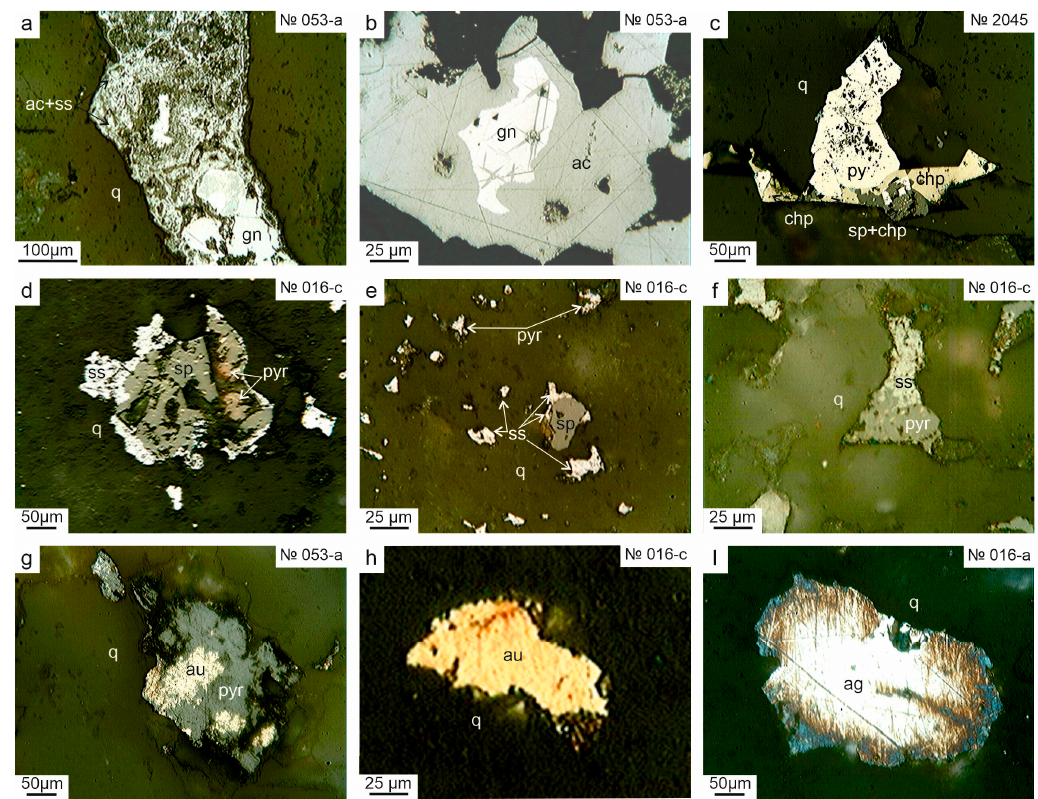
Figure 3. Mineral interrelations at the Corrida deposit: ( a )—acanthite grown on galena; ( b )—acanthite around galena and acanthite tabular isolations in galena; ( с )—assemblage of pyrite, chalcopyrite, and sphalerite impregnated with chalcopyrite emulsion; ( d , e )—sphalerite and pyrargyrite with the rim of the mineral mixture of Au-Ag sulphides; ( f )—pyrargyrite with the mineral mixture of Au-Ag sulphides; ( g )—native gold intergroup with pyrargyrite; ( h )—interstitial grain of native gold; ( i )—interstitial grain of native silver. Mineral abbreviation in Figures 3 and 4: au—native gold, ag—native silver,